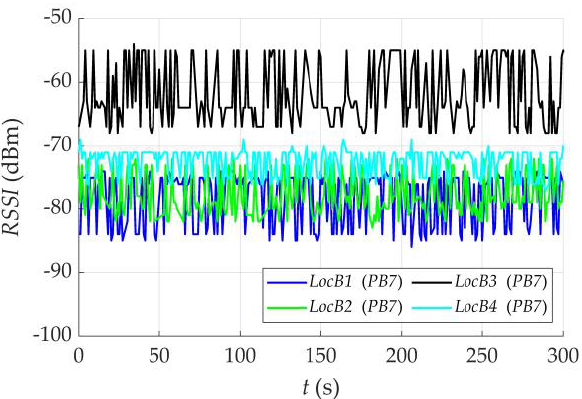
Figure 14. Measurements of RSSI values obtained by four locator nodes for an object placed in front of the LocB3 receiver at a distance of 0.5 m (location PB7 ).